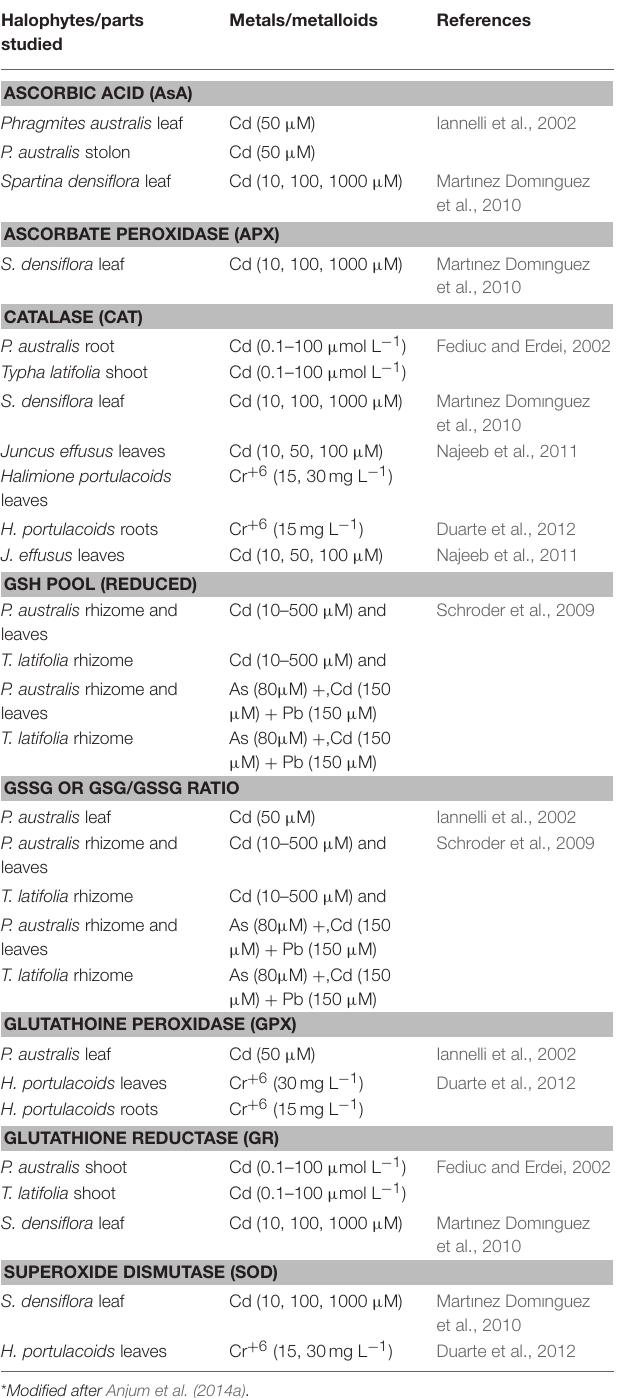
TABLE 2 | Representative studies reporting decreases in major components of antioxidant defense system in metal/metalloid-exposed salt marsh halophytes.